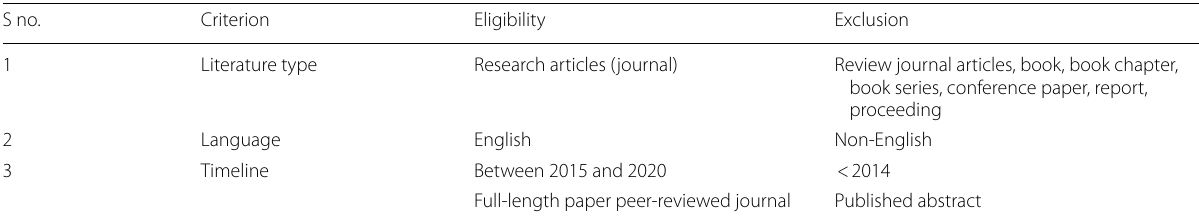
Table 1 The inclusion and exclusion criteria S